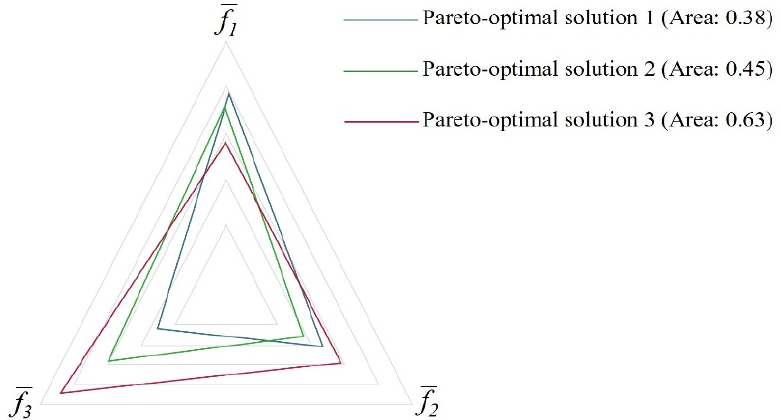
Figure 4. Radar chart used by Kitayama et al. [12] to perform the trade-off analysis. Adapted with permission from [12], 2018, Kitayama et al. [12]. Hanid et al. [34] employed two distinct expert algorithms: glowworm swarm optimization (GSO) and genetic algorithm (GA), to minimize the warpage on a frontal panel housing. Nonetheless, before performing the optimization, the authors used response surface methodology (RSM) to obtain the objective function for GSO and the fitness function for GA. The RSM can identify the correlations between independent parameters and dependent responses on 2D or 3D hyperbolic surfaces. The RSM flowchart used is presented in Figure 5.